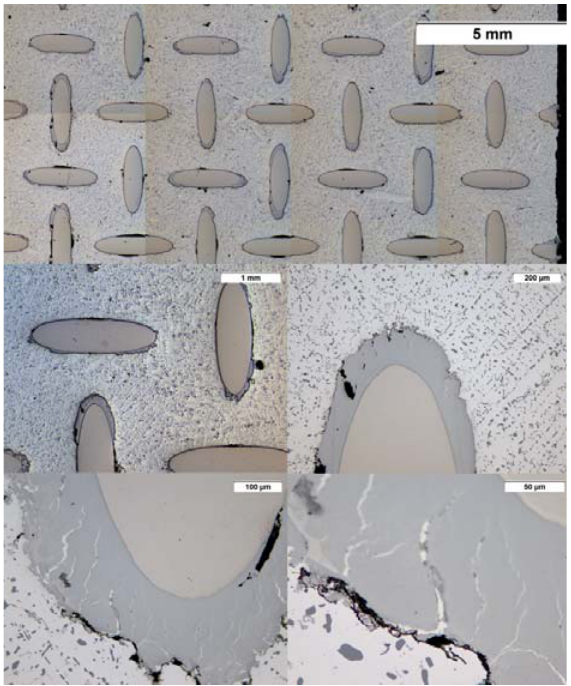
Figure 7: Optical micrographs of the two alloys and their coupling interface after solution treatment (500 °C, 10h).